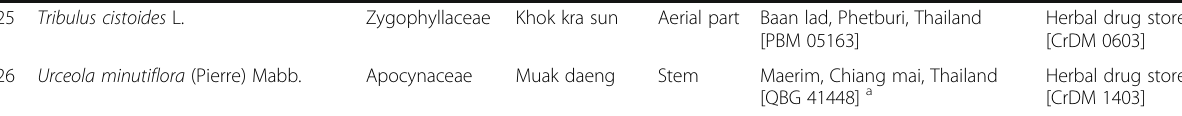
Table 1 List of the 26 component herbs of the Mathurameha herbal formula (Continued) 25 Tribulus cistoides